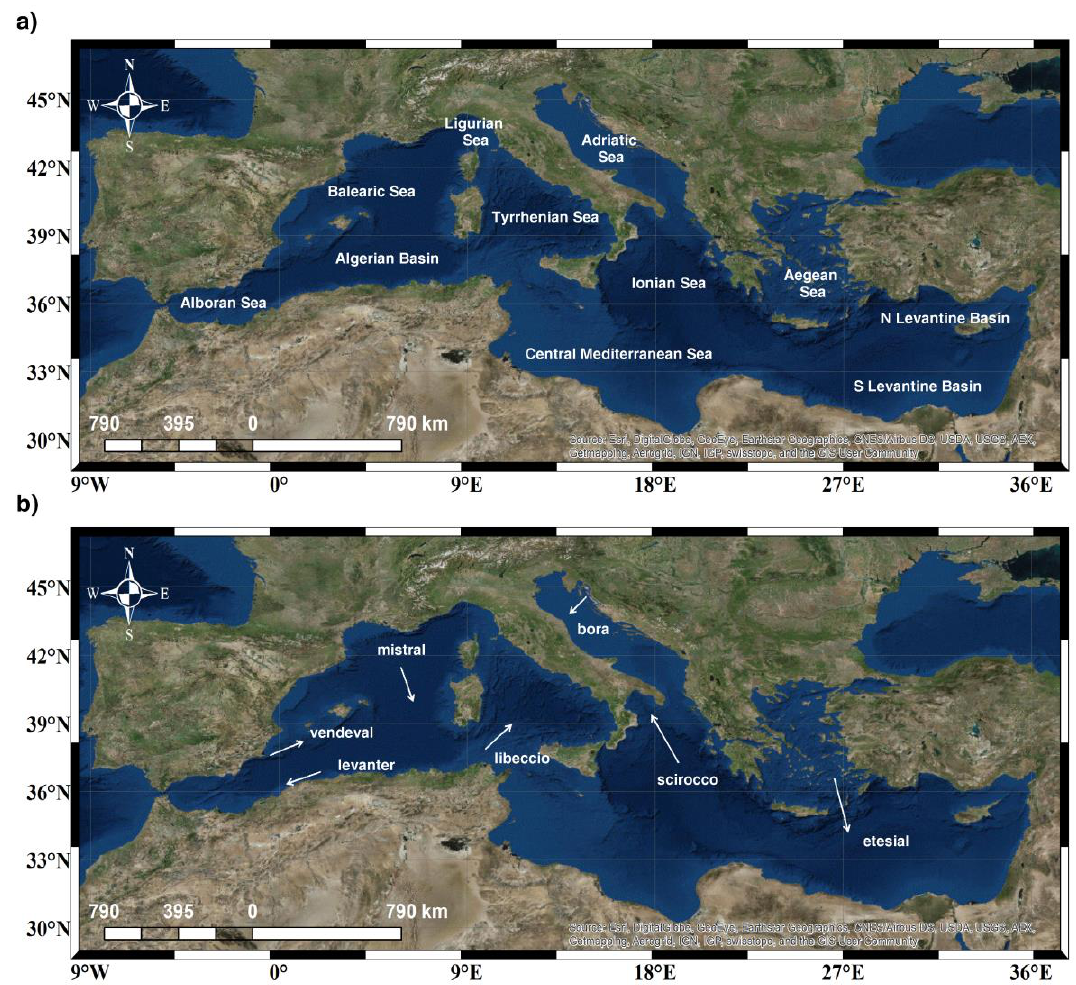
Figure 1. The Mediterranean Sea: ( a ) main basins; ( b ) regional winds.